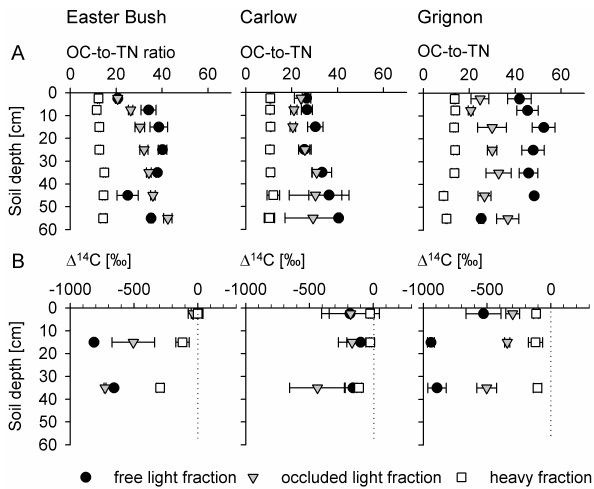
Fig. 4. Depth profiles of average OC-to-TN-ratios (A) , and the 1 14 C values of OC (B) in density fractions of the grassland site Easter Bush and the cropland sites Carlow and Grignon, all with low 1 14 C values in the light fraction.